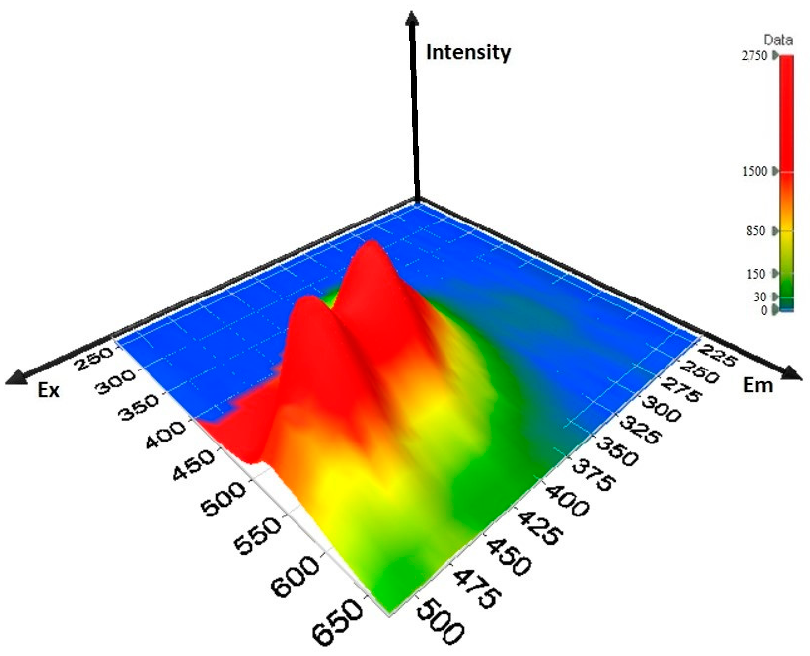
Figure 2. Characteristic 3D-EEM spectra of pine